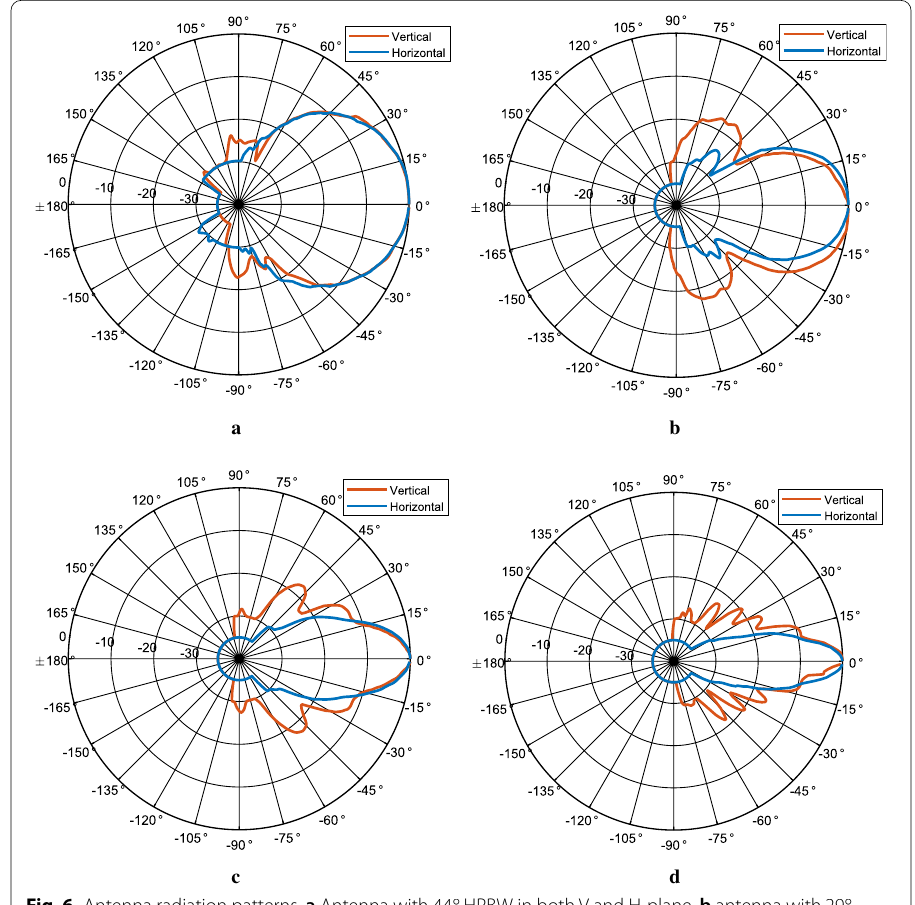
Fig. 6 Antenna radiation patterns. a Antenna with 44 ◦ HPBW in both V and H-plane, b antenna with 29 ◦ HPBW in both V and H-plane, c antenna with 16.5 ◦ HPBW in both V and H-plane and d antenna with 10 ◦ HPBW in both V and